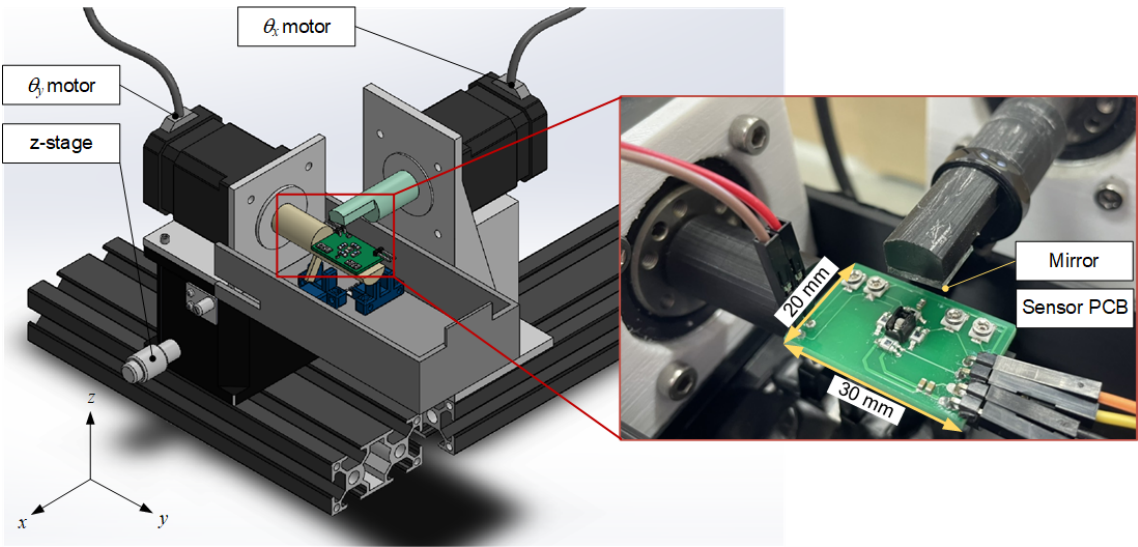
Figure 4. Test-bench consisting of two motor-driven shafts and a translational z-stage.